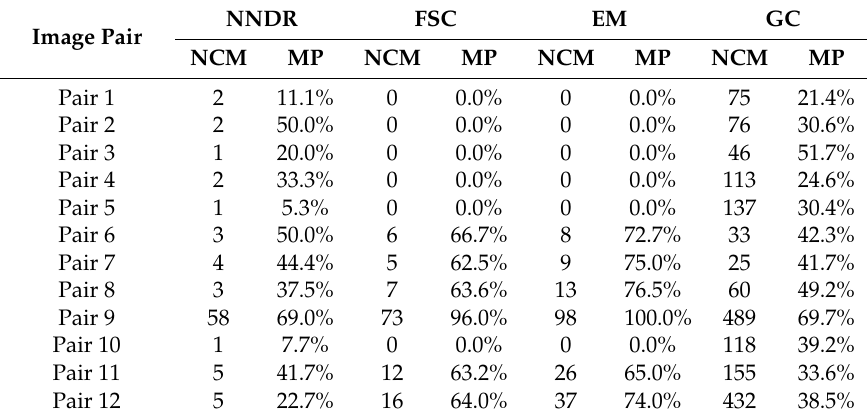
Table 7. NCM and MP values of different matching strategies.